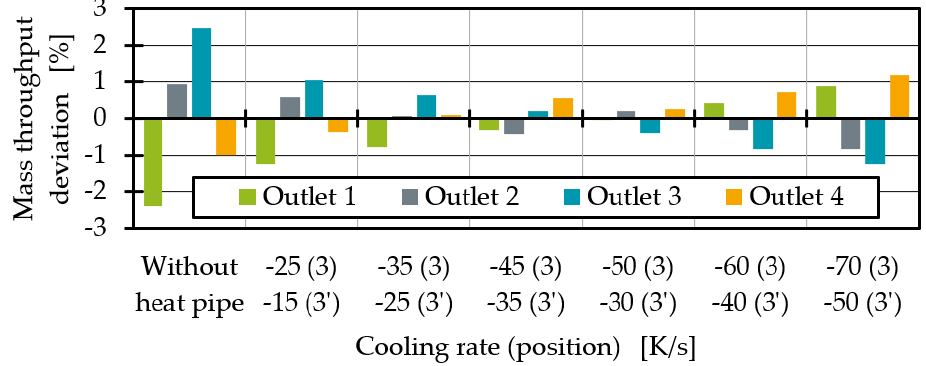
Figure 19. Average throughput deviation for two heat pipes with different performances at position 3 and 3 ′ .